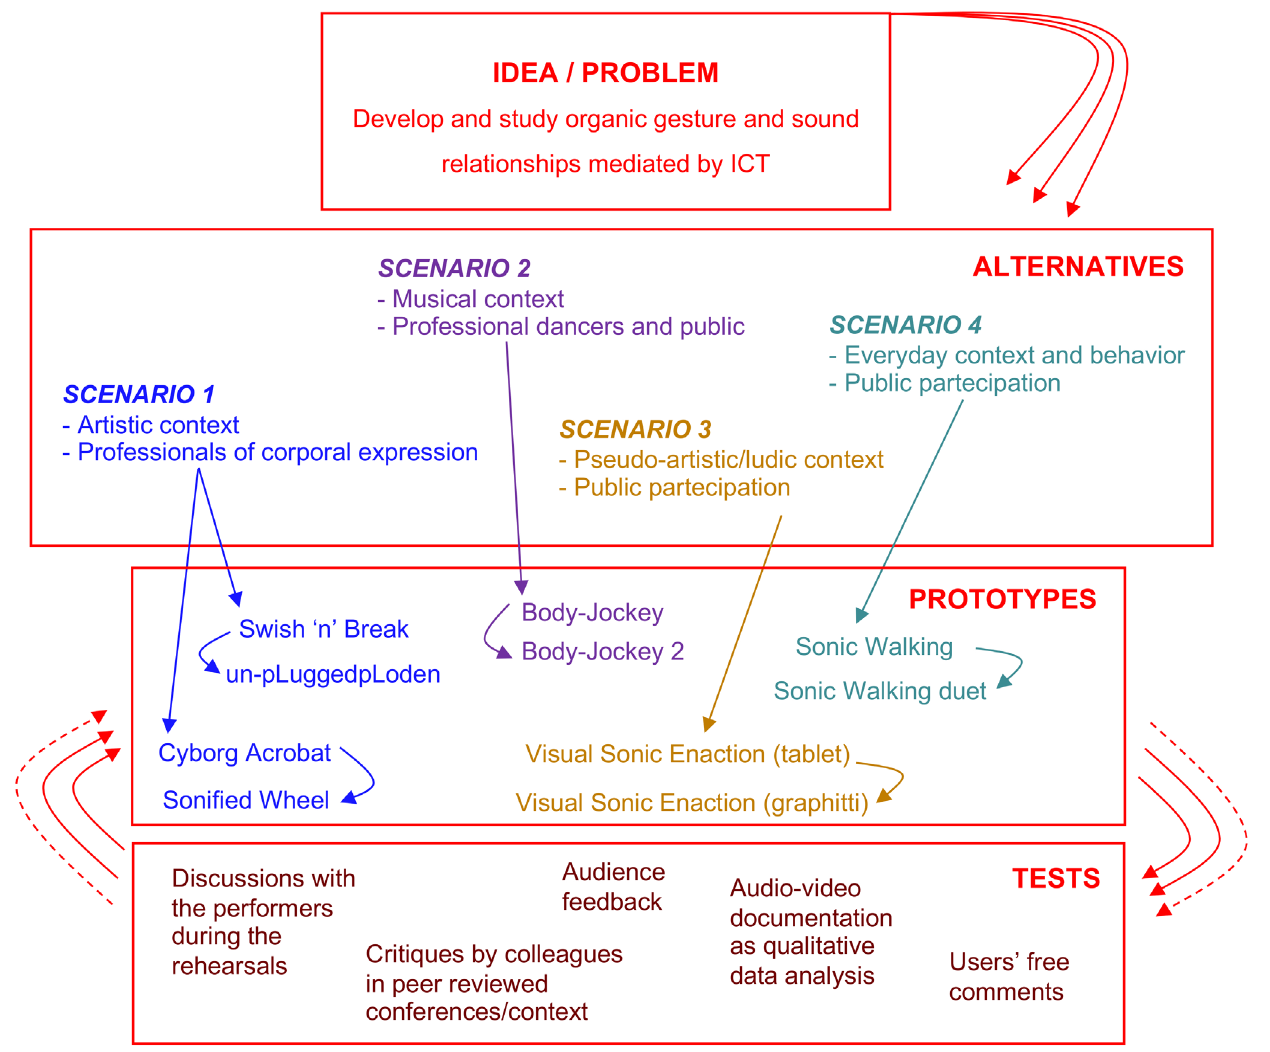
Figure 2. Gesture sonification: an artistic research project approached in an interaction design fashion. The names of the prototypes are the titles of the artworks discussed in detail in the section entitled Case Studies. The four rectangles correspond to the four iteratively cycling steps or Figure